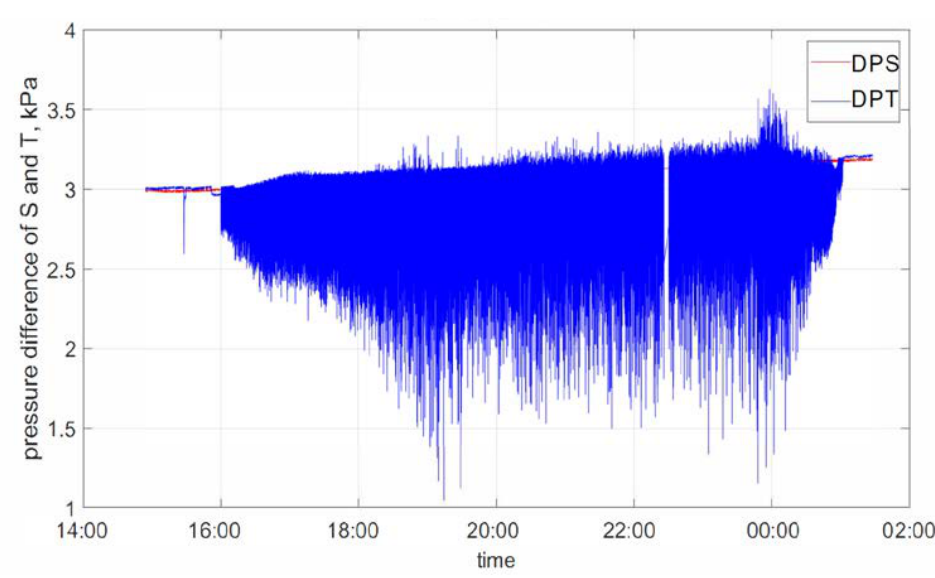
Figure 10. DPS and DPT vs. time.